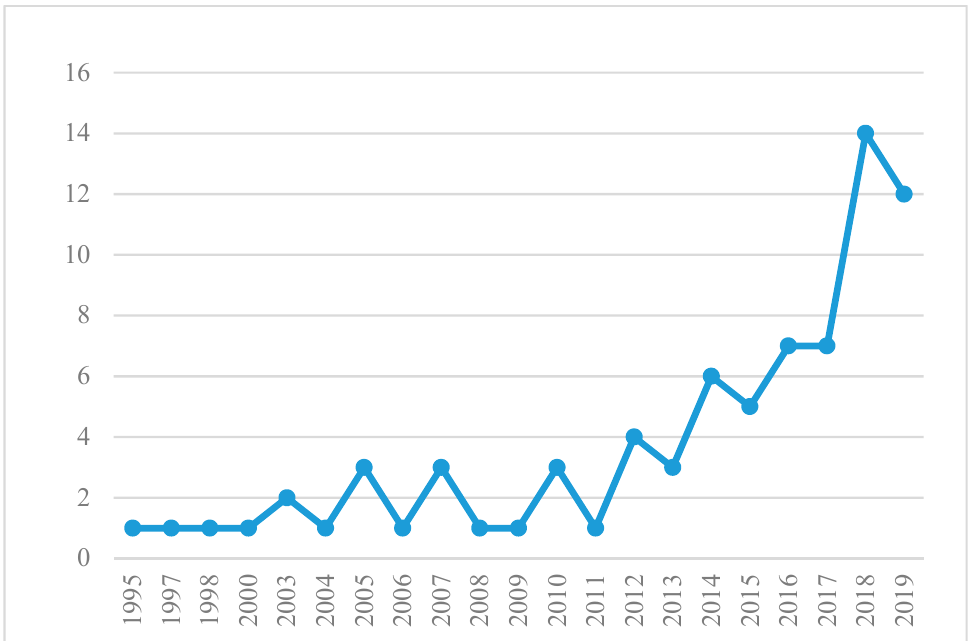
Figure 1. Number of published documents and the trend over the years. In order to safeguard the research value and analysis effect, this paper formed the inclusion and exclusion criteria for the large sample to the final analysis sample based on the above considerations. Firstly, 218 papers were obtained from the subject term search and imported into Histcite mapping analysis, excluding 41 cut-off articles with broken, uncited relationships. Secondly, the remaining abstracts were incorporated into the CiteSpace software and carefully cleaned according to the subject term hints, and disciplinary categories to remove irrelevant or non-social science papers (e.g., a paper on suppressing jealousy by a particular drug), and a total of 67 articles were excluded. After that, the uncited papers and weakly related papers (lacking a unified dialectic of envy-leadership relationship) were cleaned, and a total of 20 articles were excluded. Then, the text mining software was used to check the main idea and content of the complete text, and 12 invalid papers were eliminated from the selection process. Finally, 78 papers with analytical value, high relevance, and high documentary value were